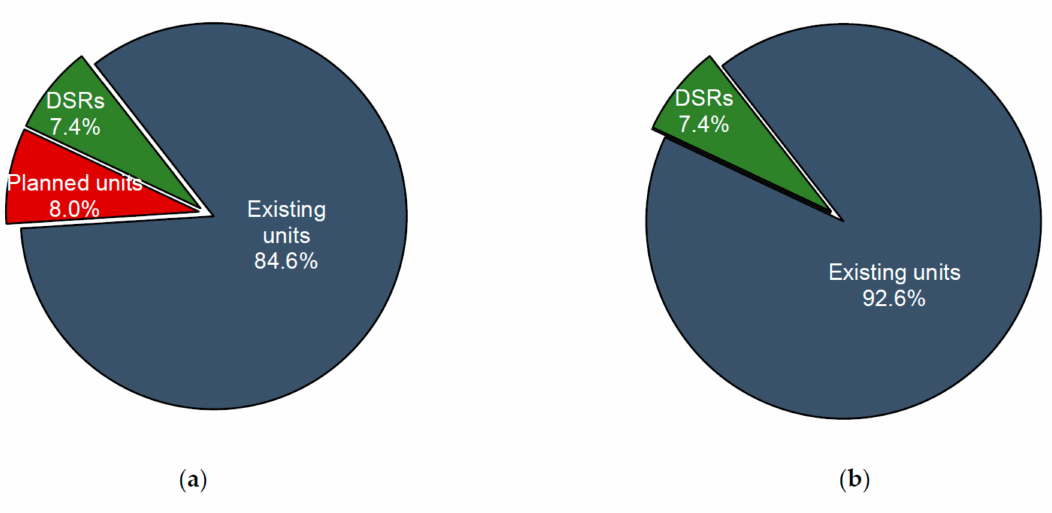
Figure 9. Structure of capacity obligation volumes contracted in main capacity auction for 2023 delivery year–break down by capacity market units: ( a ) official (declared) assignment; ( b ) actual status of capacity market units. Source: Own analysis based on